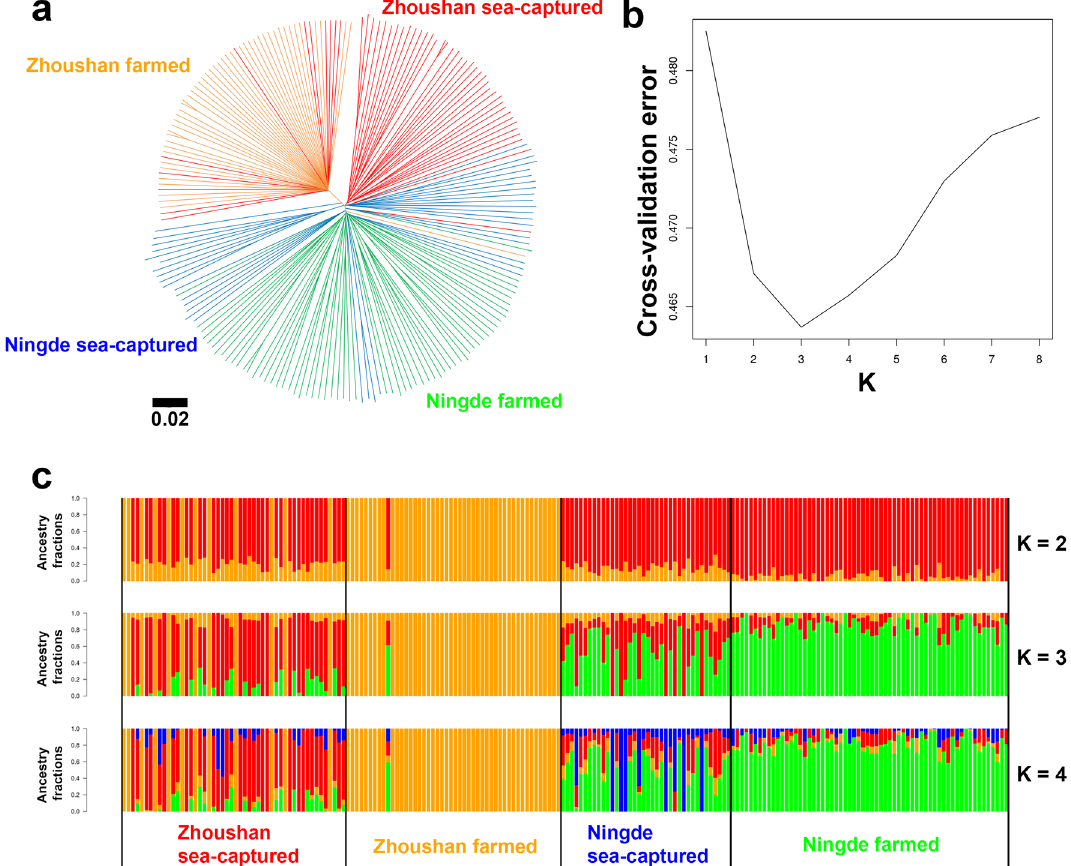
Figure 2. Neighbor-joining tree and admixture analysis using whole-genome SNP data. ( a ) Neighbor-joining tree of the 198 large yellow croaker individuals. The color scheme follows Fig. 1. The scale bar represents pairwise distances between different individuals. ( b ) Cross-validation error in the admixture analysis. The x-axis represents K values and the y-axis represents the corresponding cross-validation error. The cross-validation error was lowest at K = 3. ( c ) Admixture plot (K = 2, 3, 4) for the 198 large yellow croaker individuals. Each individual is shown as vertical bar divided into K colors. The color scheme follows Fig. 1. Individuals are arranged by population